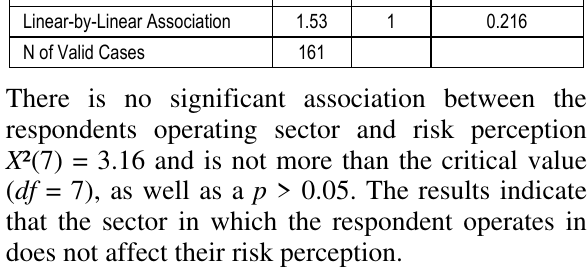
Table 13. Number of years in operation versus risk